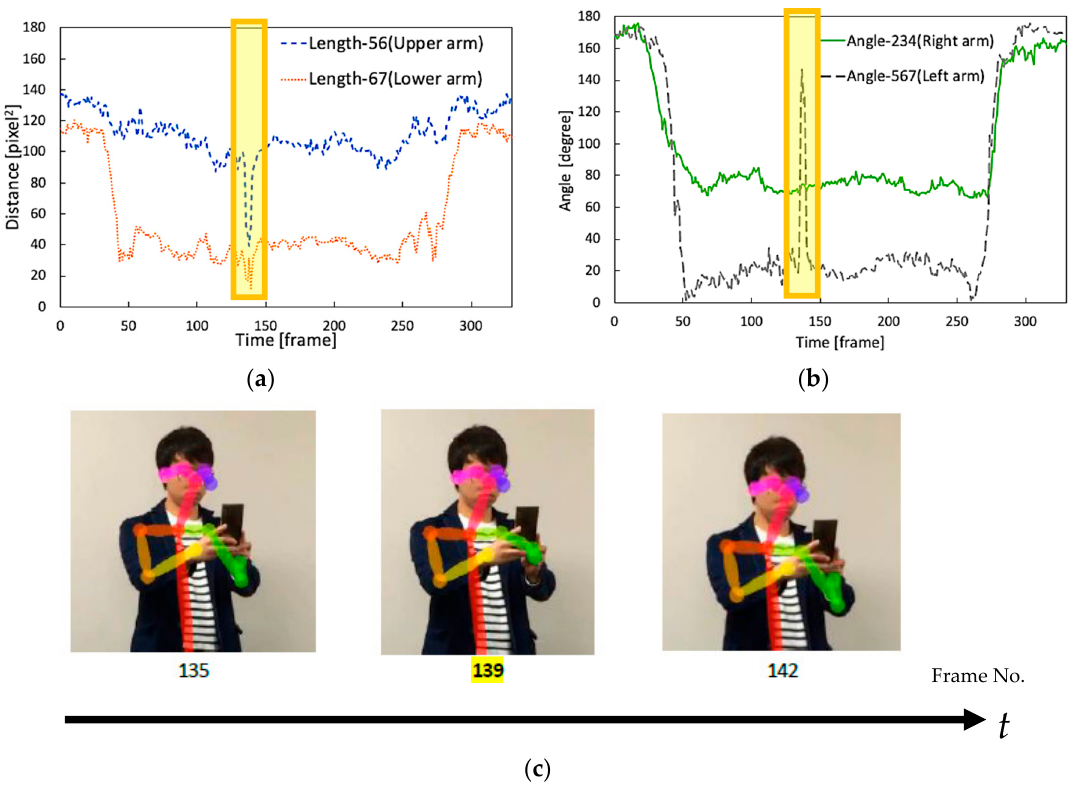
Figure 13. Example 1 of misdetection generated by OpenPose (taken from P1). ( a ) Left upper and left lower arm’s lengths; ( b ) angles of right bending and left bending arms; ( c ) Example frame (135th, 139th, and 142nd).